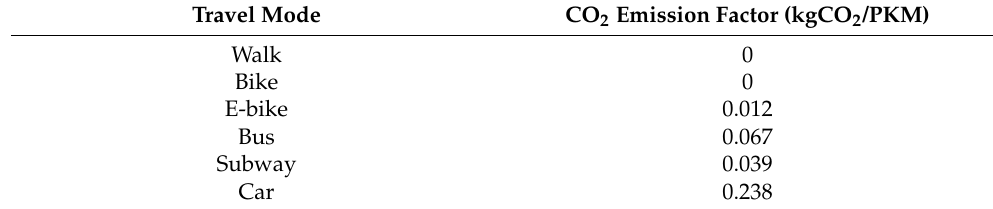
Table 3. CO 2 emission factors per